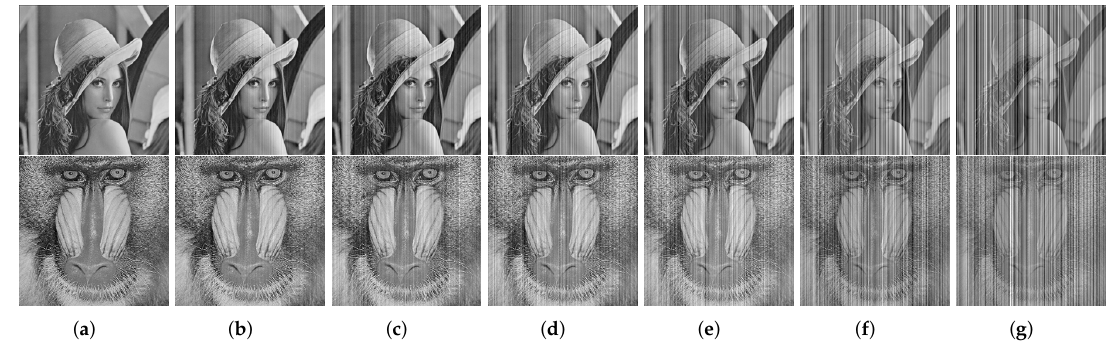
Figure 4. Two sets of simulated noisy images for testing. ( a ) Clean images Lena and Mandrill; ( b – g ) Noisy images Lena and Mandrill with stripe noise of σ = 0.02,0.04,0.08,0.16,0.32, respectively.